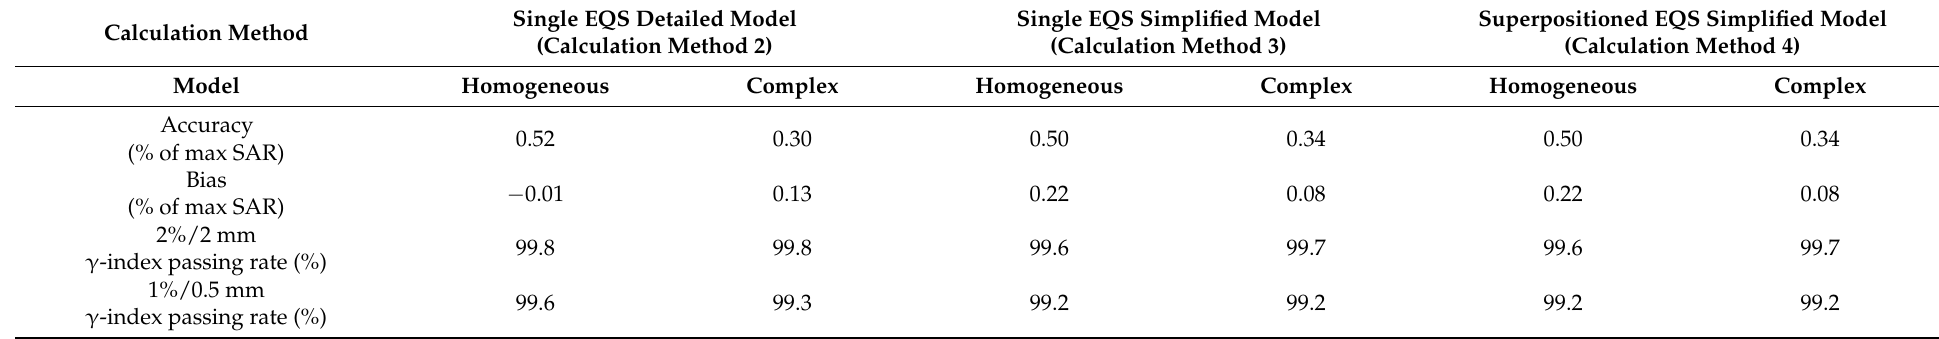
Table 4. Summary of evaluation results of the three EQS calculation methods compared to the golden standard FDTD calculation method on the homogeneous and complex benchmarking